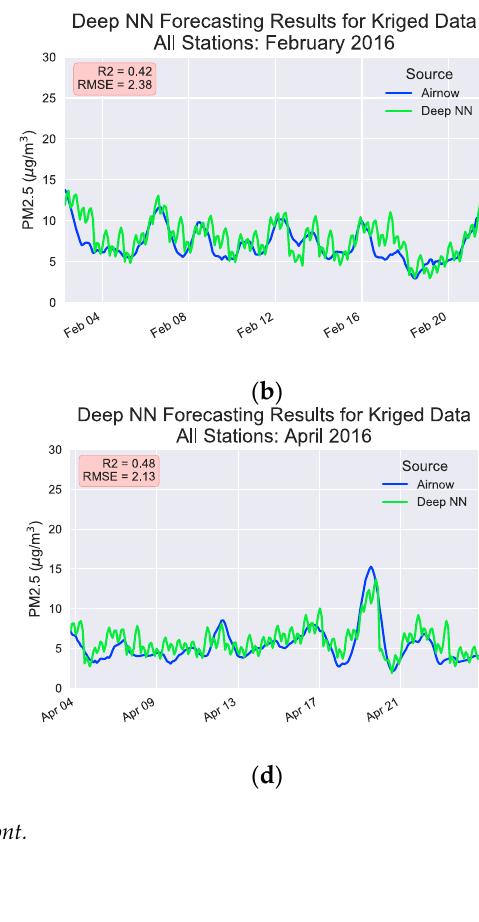
Figure A2. Regression analysis, deep neural network ( a – m ). The regression analysis was computed for the comparison between AirNow observations and the various prediction models. The R 2 values comparing the models to the observations are plotted in the figures to compare CMAQ to the DNN. The CMAQ model here includes only the bias-corrected, 12:00 UTC zero forecast hour, model. This model was chosen because it generally produces the best forecasting results for CMAQ.